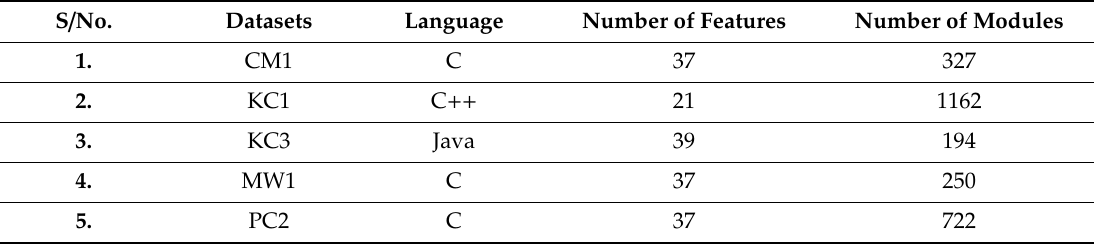
Table 5. Software Defect